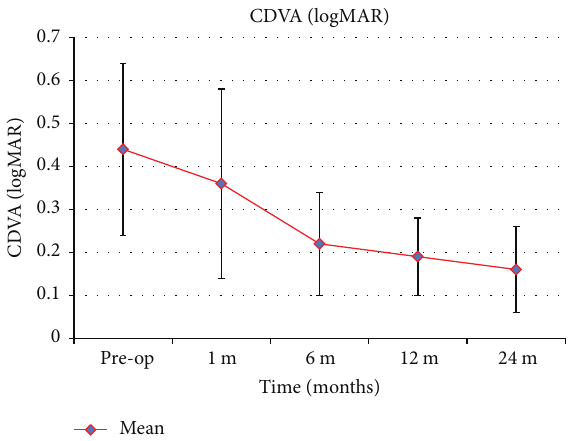
Figure 2: Mean CDVA over time. The error bars represent the SD in logMAR (CDVA: corrected distance visual acuity).